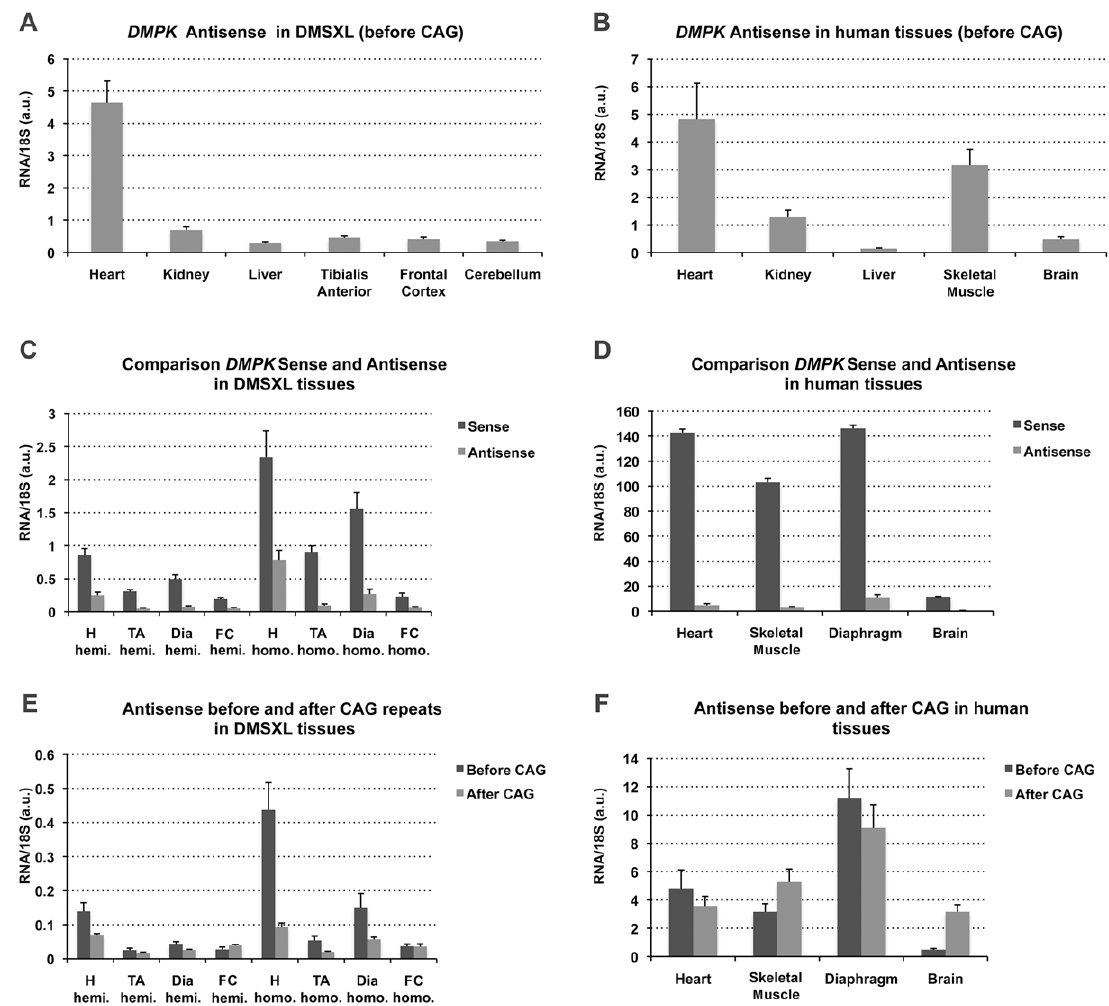
Figure 3. Expression of sense and antisense DMPK transcripts. (A–B) DMPK antisense expression profile in 4-month-old DMSXL homozygotes (n=3) and human control adult tissues (commercial panel) using amplicon B 9 located upstream the CAG repeat. (C–D) Comparison of DMPK sense and antisense transcript levels in 4-month-old DMSXL homozygotes (n=3) and human control tissues. (E–F) Comparison of antisense transcript levels measured in 5 9 (before) and in 3 9 (after) of the CAG repeat using amplicons B 9 and C 9 in DMSXL and control human tissues. H, heart; TA, tibialis anterior; Dia, diaphragm; FC, Frontal Cortex; Hemi., Hemizygous; Homo. Homozygous. Data are presented as means 6 standard deviation in arbitrary units (a.u.).